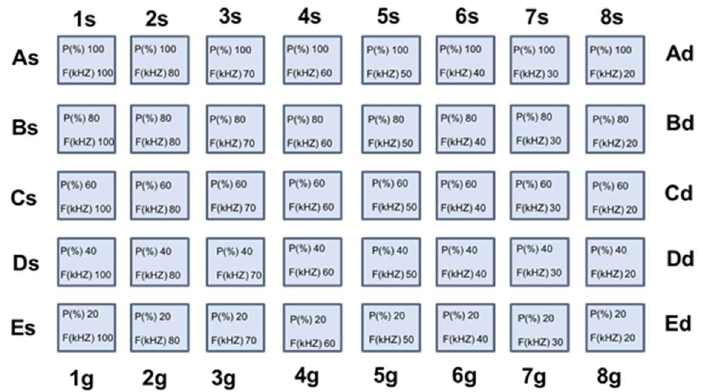
Figure 1. General matrix of laser treatment where two of the main laser parameters, as programmed by computer, are reported: maximum power percentage and pulse frequency.